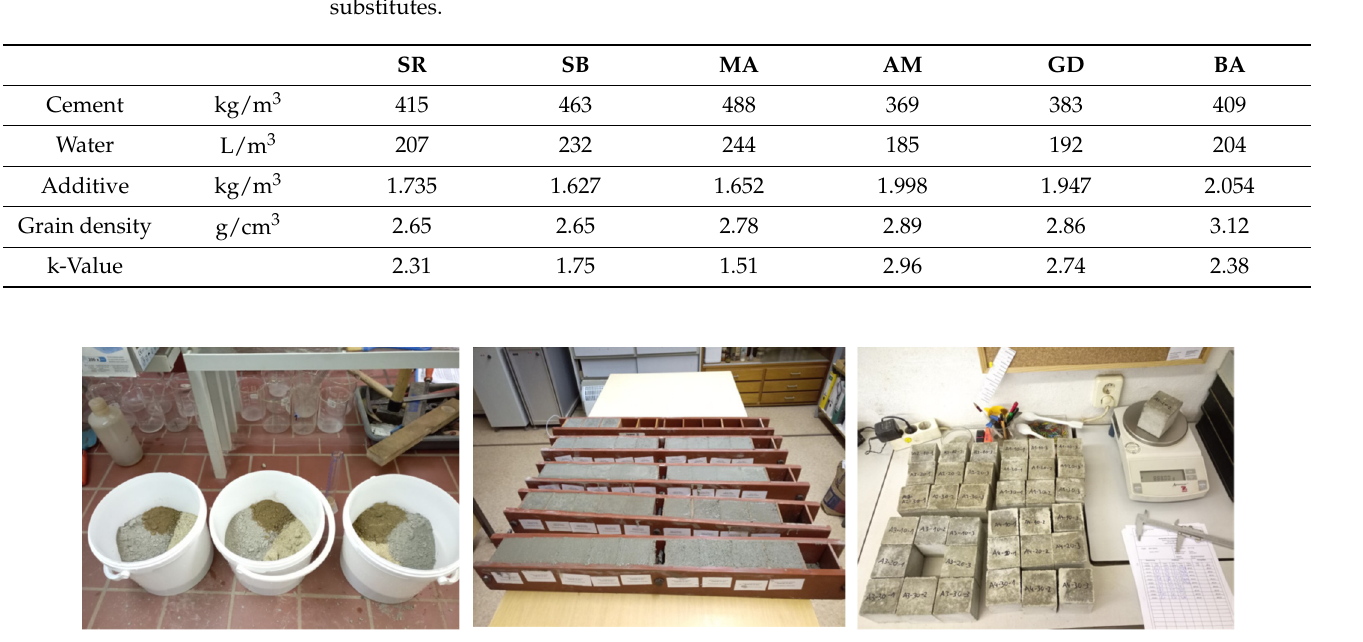
Table 1. Base formulations for concrete of strength class C 25/30 with potential primary m-sand substitutes.